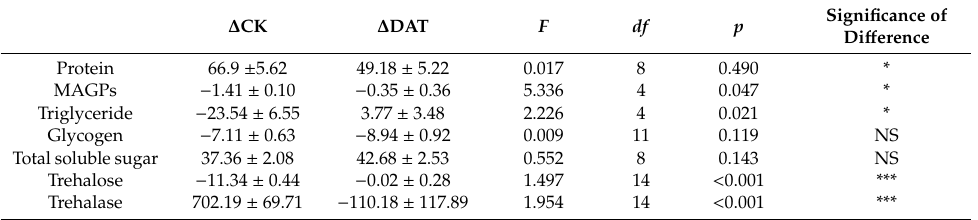
∆CK denotes the difference between “postmating” and “premating” values; ∆DAT denotes the difference between “postmating” and “premating” values. Data in the figure are presented as the mean ± SEM. NS, no significant difference, *, p < 0.05, ***, p < 0.001 (Tukey’s test).